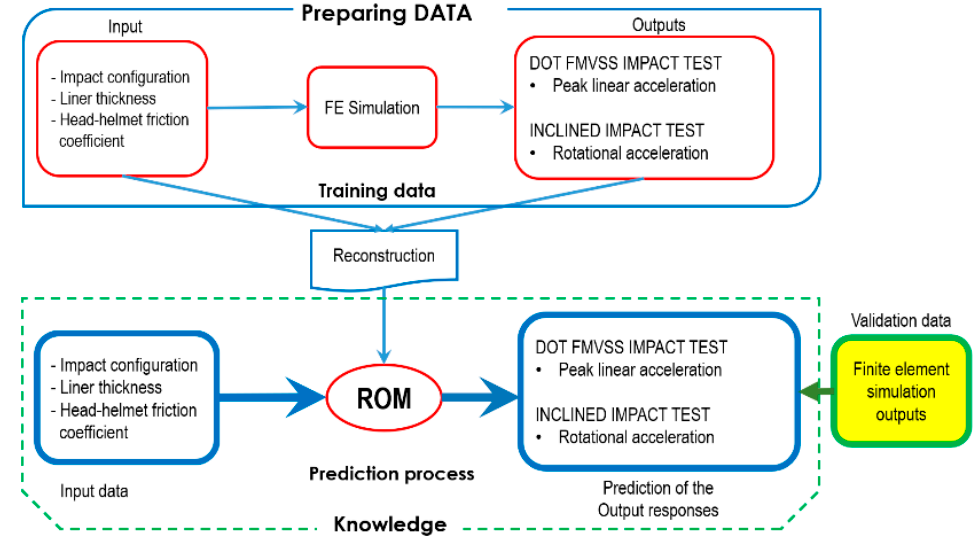
Figure 6. Reduced ‐ order model establishment process. Figure 6. Reduced-order model establishment